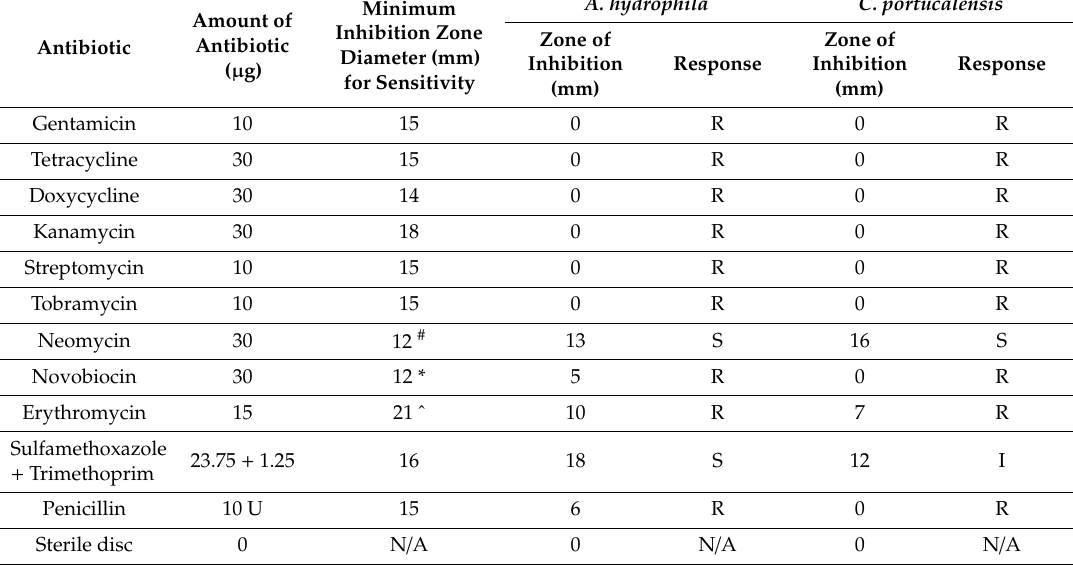
Table 1. Antibiotic susceptibility tests for A. hydrophila and C. freundii on Mueller-Hinton agar, using BD di ff usion discs, pre-loaded with fixed amounts of antibiotics. Sulfamethoxazole * = sulfamethoxazole 23.75 µ g + trimethoprim 1.25 µ g. The inhibition zone diameters for